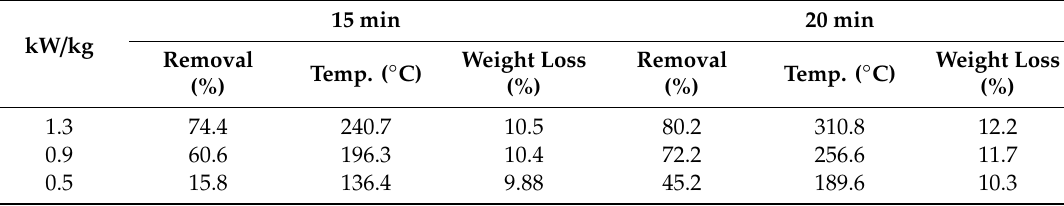
Table 3. Total petroleum hydrocarbon (TPH) removal (%), temperature ( ◦ C) and weight loss (%) from contaminated soil with irradiation time (15 and 20 min,